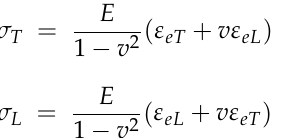
Figure 2. Positions in residual stress measurement.